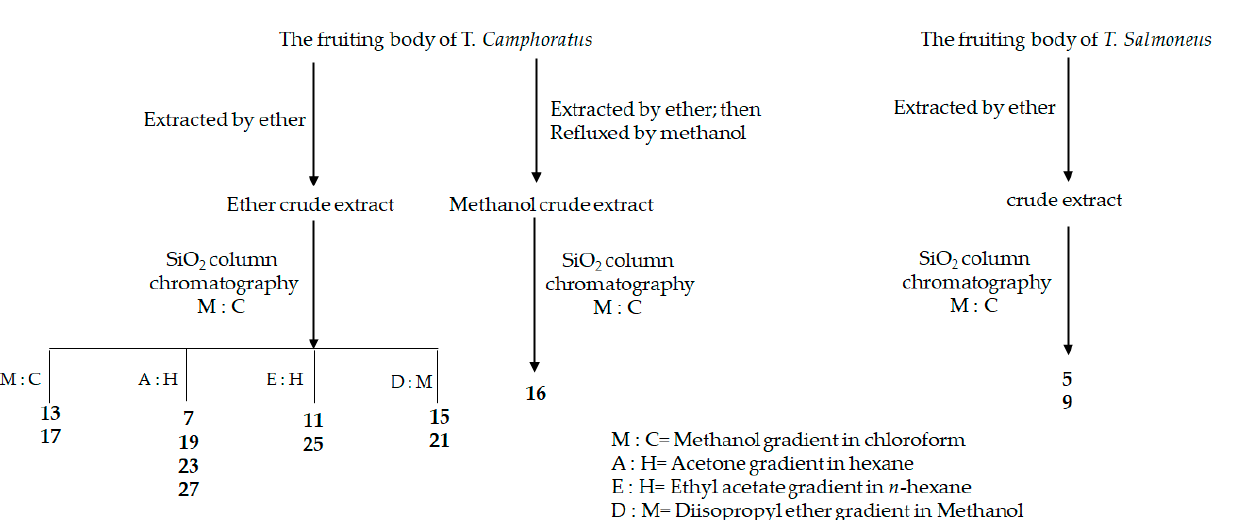
Figure 1. Cytotoxicity of compound 1 – 4 isolated from T. camphoratus on KBvin cell lines.